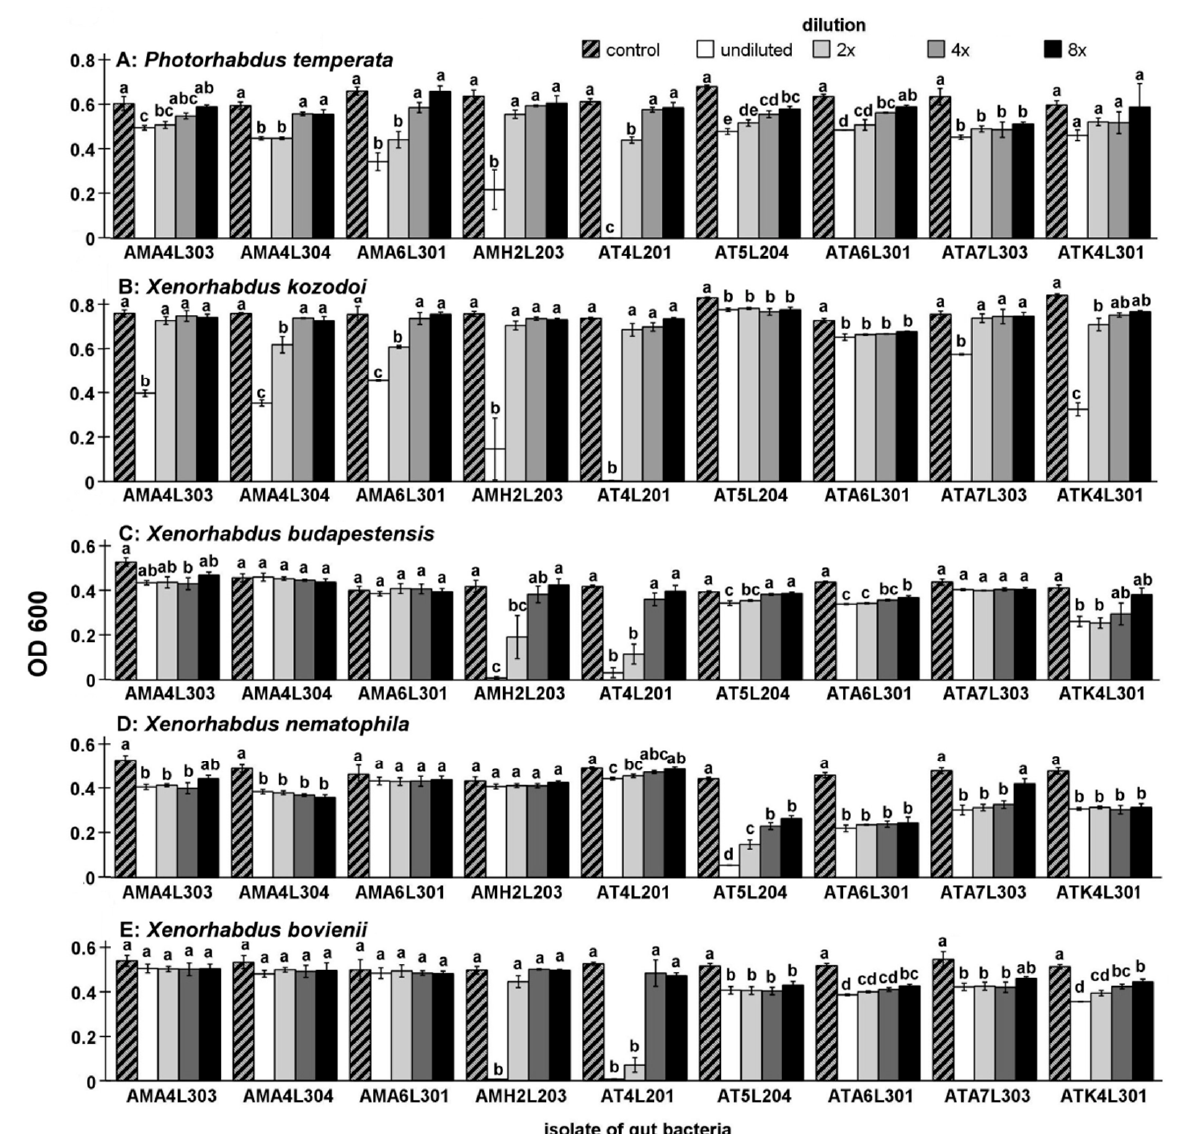
Figure 2. Differences in the antibacterial activities of increasing dilutions of supernatants from selected A. solstitiale gut isolates against P. temperata ( A ), X. kozodoi ( B ), X. budapestensis ( C ), X. nematophila ( D ) and X. bovienii ( E ) in the MID tests. The same letters above bars in the group mean no statistically significant differences between the inhibitory activity of supernatants.